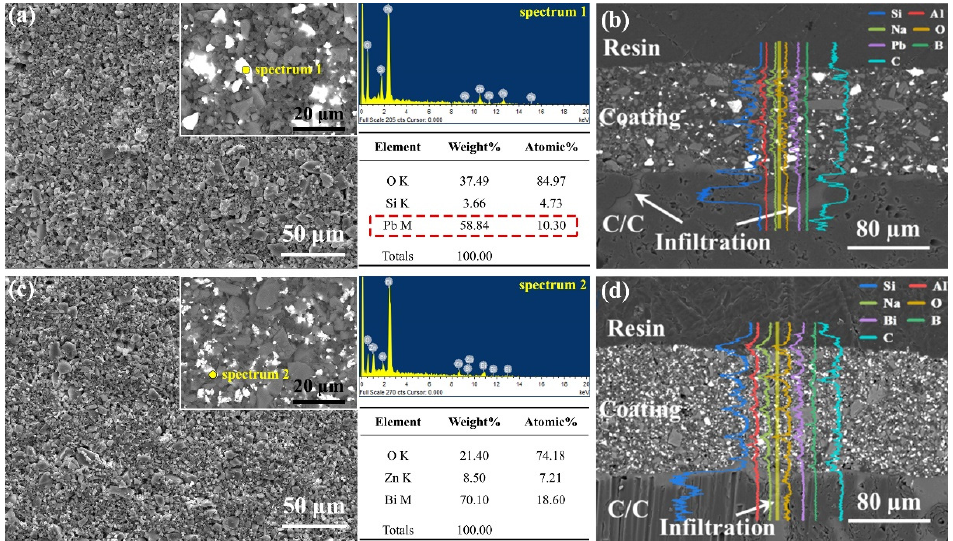
Figure 3. SEM and enlarged backscattered electron (BSE) images of the coating: ( a ) surface of the PSN/lead–borosilicate glass–B 4 C coating and corresponding EDS analysis; ( b ) cross- sectional image and EDS line results of PSN/lead–borosilicate glass–B 4 C coating; ( c ) surface of the PSN/bismuth–borosilicate glass–B 4 C coating and corresponding EDS analysis; and ( d ) cross- sectional image and EDS line results of PSN/bismuth–borosilicate glass–B 4 C